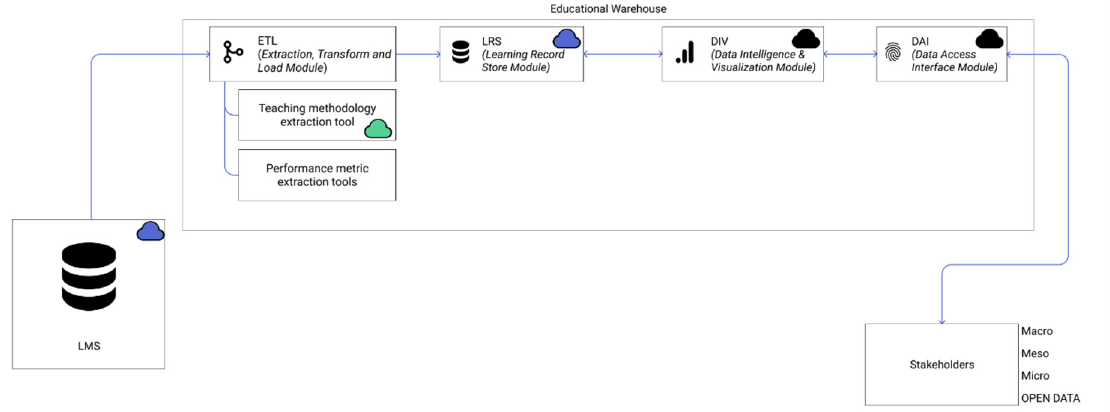
Figure 5. The educational warehouse architecture proposal for a cloud-based deployment: each colored cloud represents a different environment. The lack of a cloud symbol means that it is a local component.